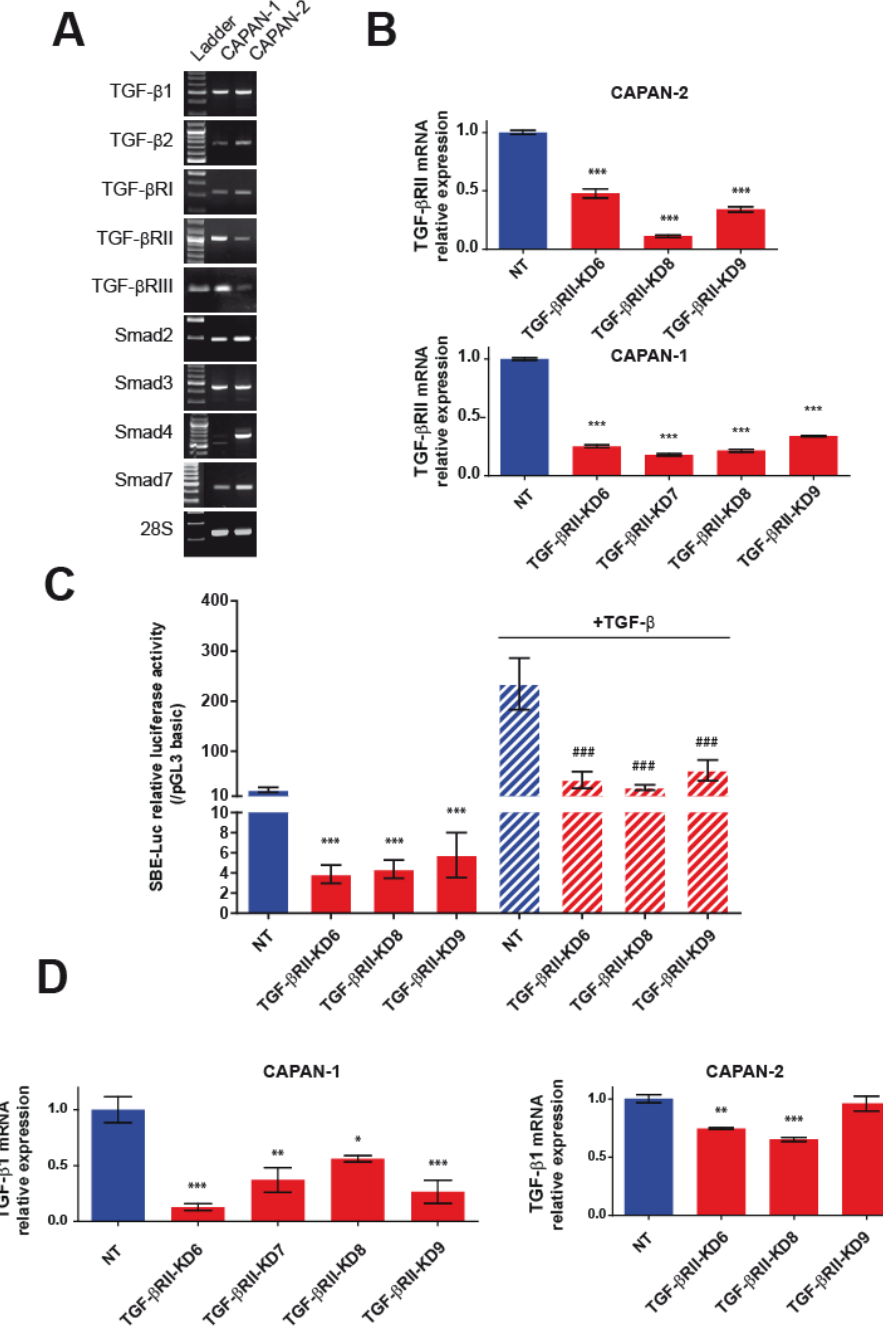
Figure 1. Characterization of TGF- β/Smad pathway in TGF- βRII -KD CAPAN-1 and CAPAN-2 cell lines. ( A ) Analysis of mRNA expression of TGF- β1, TGF - β2, TGF - βRI, TGF - βRII, TGF - βRIII, Smad2, Smad3, SMAD4, Smad7 and 28S in CAPAN-1, CAPAN-2 cells by RT – PCR. ( B ) Analysis of mRNA relative expression of TGF- βRII in NT and TGF - βRII -KD CAPAN-1 and CAPAN-2 cell lines. Expression in NT cells was arbitrarily set to 1. ( C ) Smad-Binding-Elements (SBE)-Luc relative luciferase activity in untreated and TGF- β treated NT and TGF - βRII -KD CAPAN-2 cells. Relative luciferase activity was expressed as a ratio of SBE-Luc normalized with pGL3 basic activity. ( D ) Analysis of mRNA relative expression of TGF- β1 in NT and TGF - βRII -KD CAPAN-1 and CAPAN-2 cell lines. N = 3. * p < 0.05, ** p < 0.01 and *** p < 0.001 indicate statistical significance compared with the NT control. ### p < 0.001 indicate statistical significance compared with the TGF- β treated NT control.